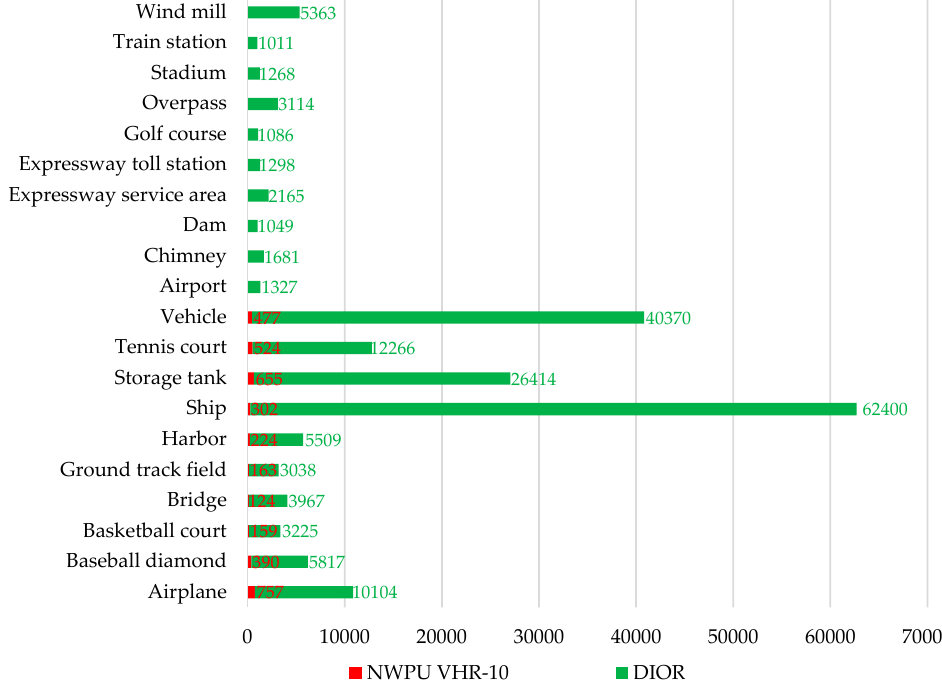
Figure 4. Total number of object instances of each category in two datasets.